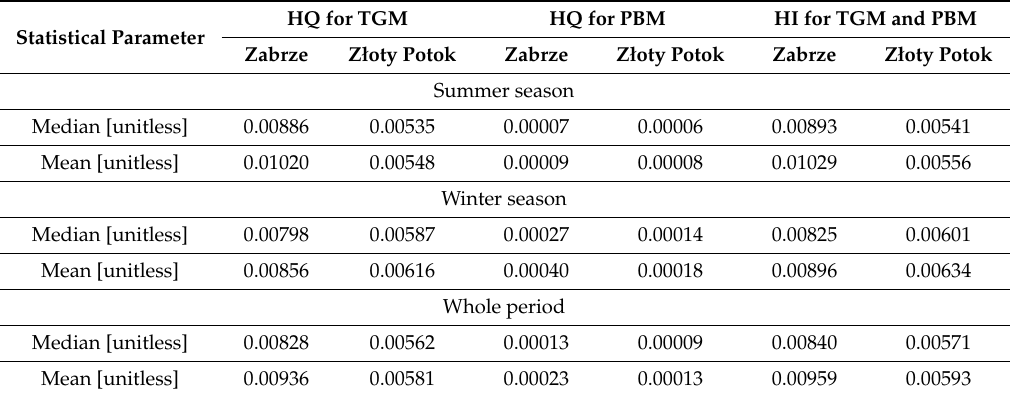
Table 4. The median and mean of hazard quotients (HQ) and hazard indexes (HI) for TGM and PBM concentrations in Zabrze and Złoty Potok (2014–2015) and the actual EPA’s reference concentration RfC = 0.3 µ gm − 3 .